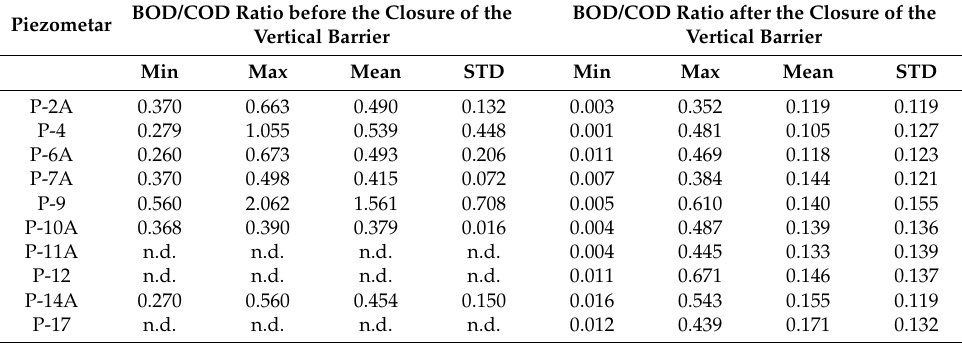
Table 3. BOD/COD ratio for groundwater samples collected in the study area. Piezometar